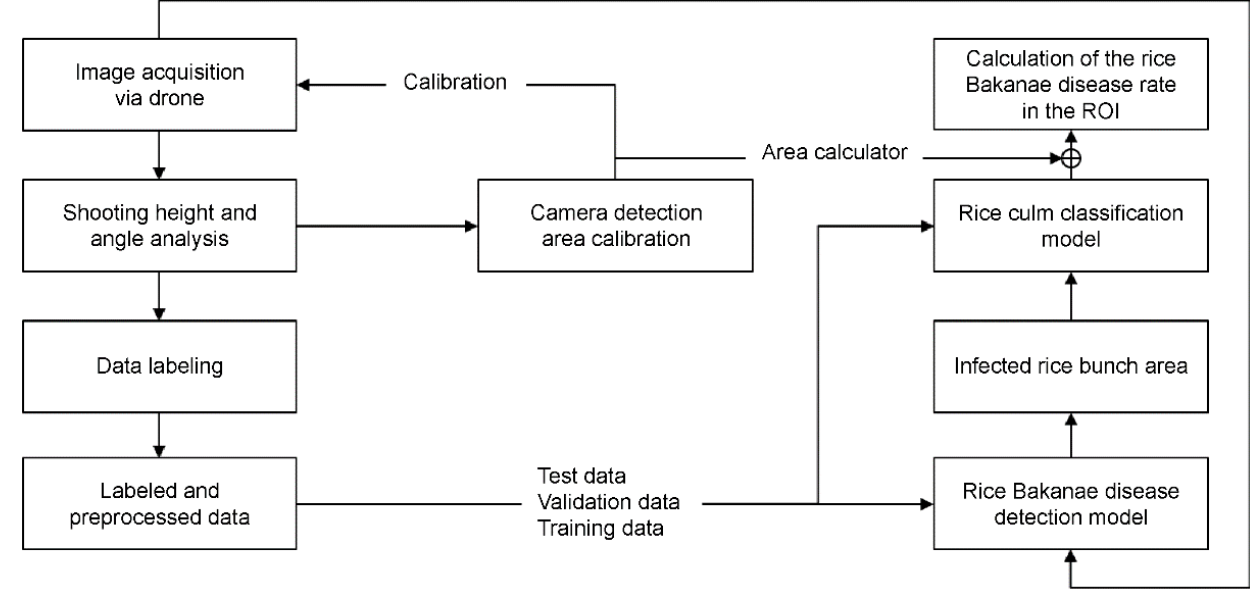
Figure 5. The system structure for reading the RBD-infected.